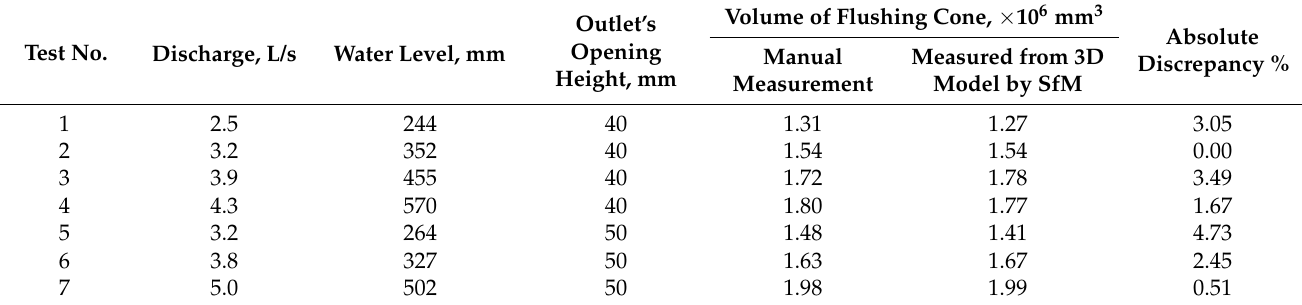
Table 5. Boundary conditions and measured volume of flushing cone for tests conducted in Case Study III.